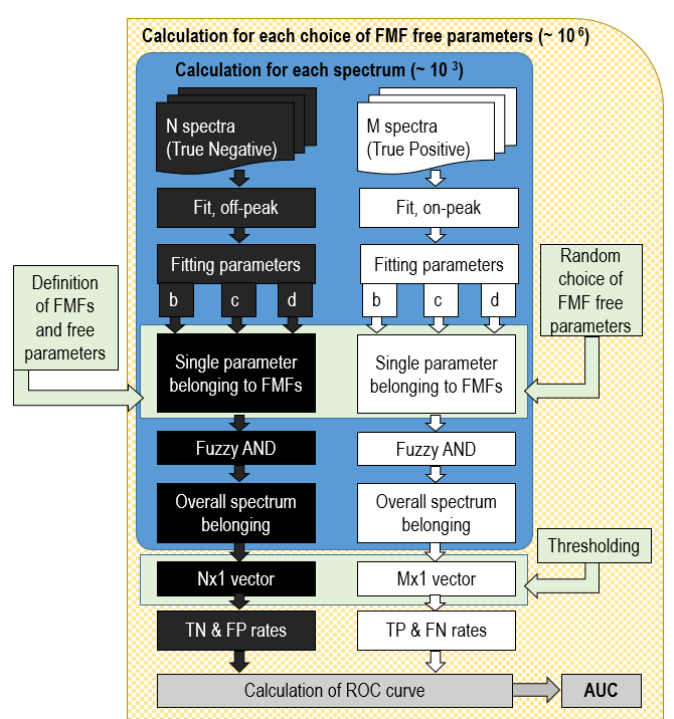
Figure 4. Flow chart of the algorithm for recognition of a single peak. In our case, N = M = 1000